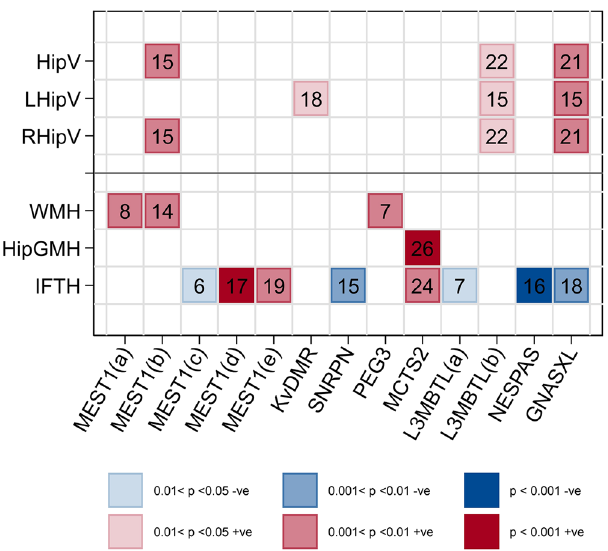
Figure 4. Heatmap showing significant blocks of association between imprint methylation and change in hippocampal volumes (in mm 3 ) and hyperintensities between MRI imaging at baseline and follow-up in ABC36 participants following permutation analysis (HipV = hippocampal volume; LHipV = left hippocampal volume; RHipV = right hippocampal volume; WMH = white matter hyperintensities; HipGMH = grey matter hyperintensities specific to the hippocampus; IFTH = infratentorial hyperintensities). Blue indicates negative assoctions and red positive. Colour gradients represent level of significance with most intense colour indicating the highest level of significance. Numbers of significant CpG sites in the association block are shown. Imprints are organised in chromosomal order along the x-axis and vertically aligned squares cover the same CpG blocks. Created using STATA/MP version 15 (StataCorp. 2017. Stata Statistical Software: Release 15 . College Station, TX: StataCorp